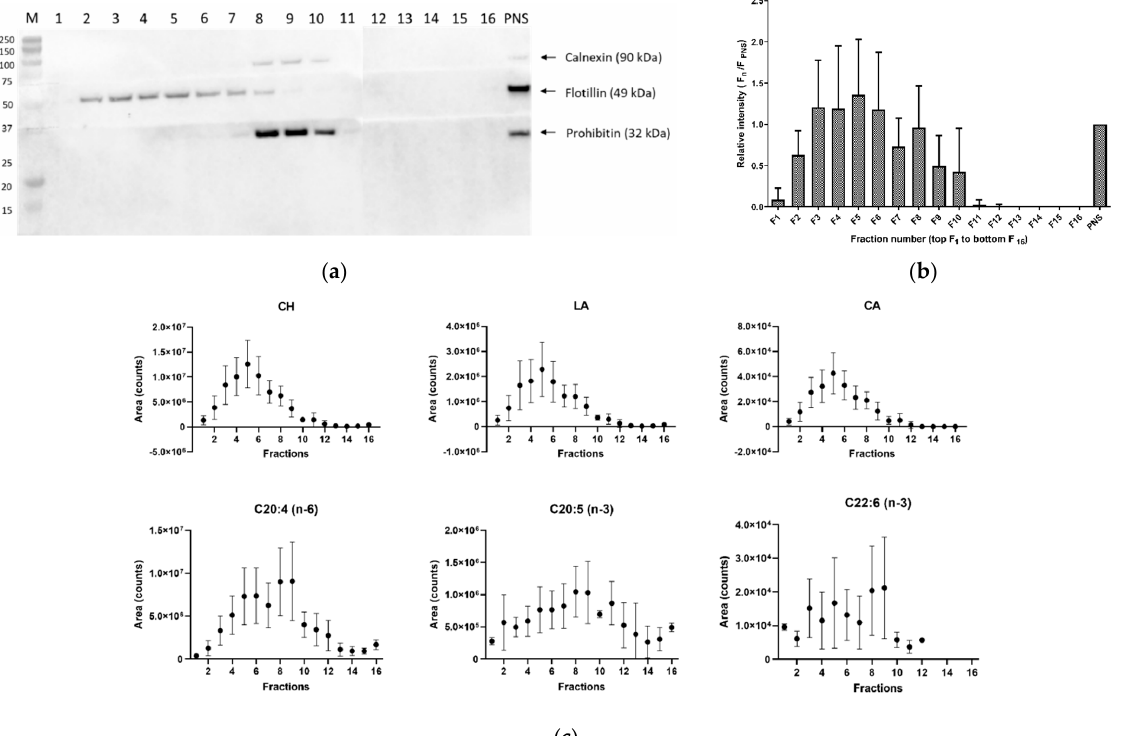
Figure 1. Cell membrane fractions were analyzed and evaluated using Western blot and LC-MS/MS. ( a ) Representative Western blot analysis of membrane microdomain fractions (flotillin − 1), and mito- chondrial and endoplasmic reticulum (prohibitin 1 and calnexin markers, respectively) membranes in all isolated fractions ( n = 16), obtained after ultracentrifugation of murine SIM − A9 microglia; ( b ) relative band intensity of flotillin − 1 (using Western blot, n = 5); ( c ) LC-MS/MS analysis based on peak areas of cholesterol (CH), lanosterol (LA), campesterol (CA) and polyunsaturated fatty acids (ARA C20:4 (n − 6), EPA C20:5 (n − 3) and DHA C22:6 (n − 3)) in five consecutive isolations. Data are expressed as mean ± SD of five consecutive isolations. PNS: post-nuclear supernatant;